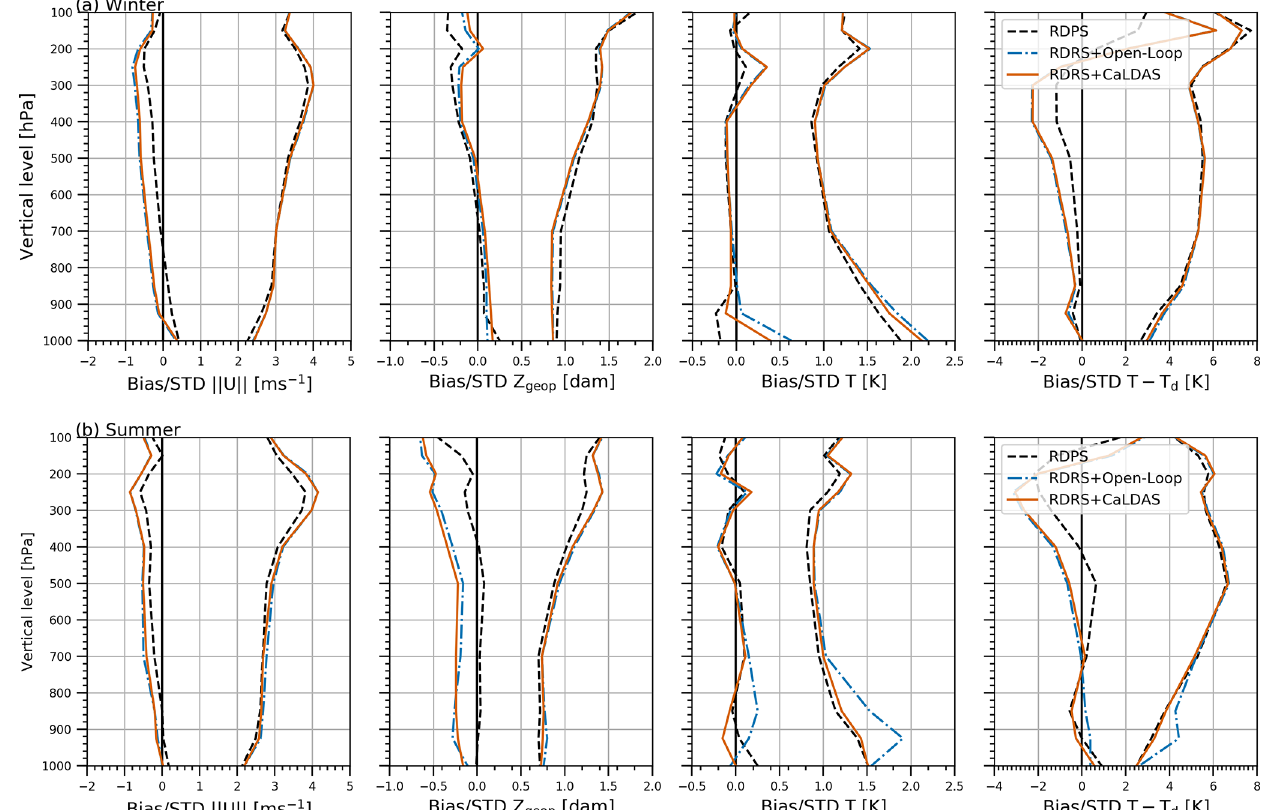
Figure 4. Comparison of atmospheric results from operational RDPS (black dashed line), RDRS + Open-Loop (blue dashed–dotted line) and RDRS + CaLDAS (orange continuous line) after 24h integration against radiosonde for the whole North America (from left to right: wind modulus, geopotential height, absolute temperature, dew point depression): (a) February and March 2011; (b) July and August 2011. In each of the panels the curves on the left show the bias while the curves on the right show the